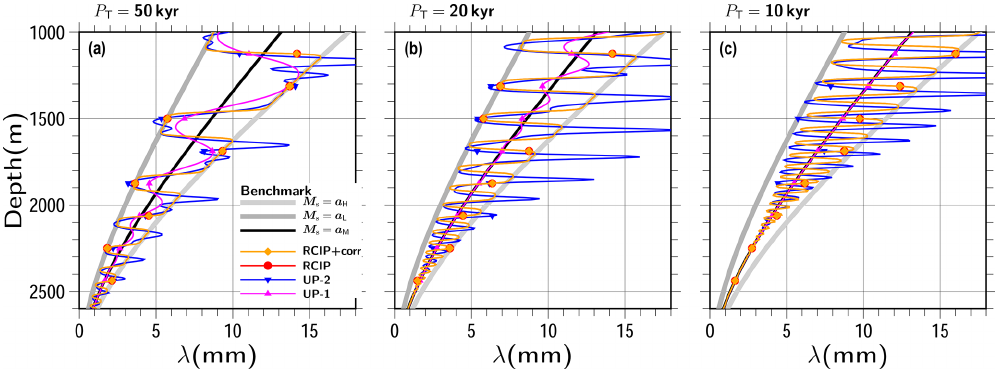
Figure 16. Same as Fig. 15, except for the vertical resolution, which is shown as a uniform grid spacing of 513 levels. The results at 2000kyr covering the depth from 1000 to 2600m are shown.